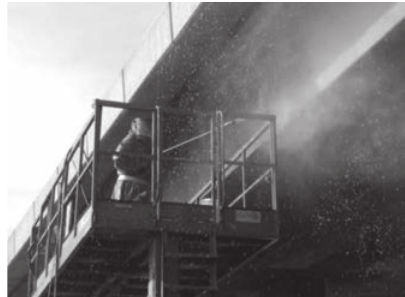
Fig. 1. Repair of road bridge in Brno (Czech Republic) using hand-held water jet lance